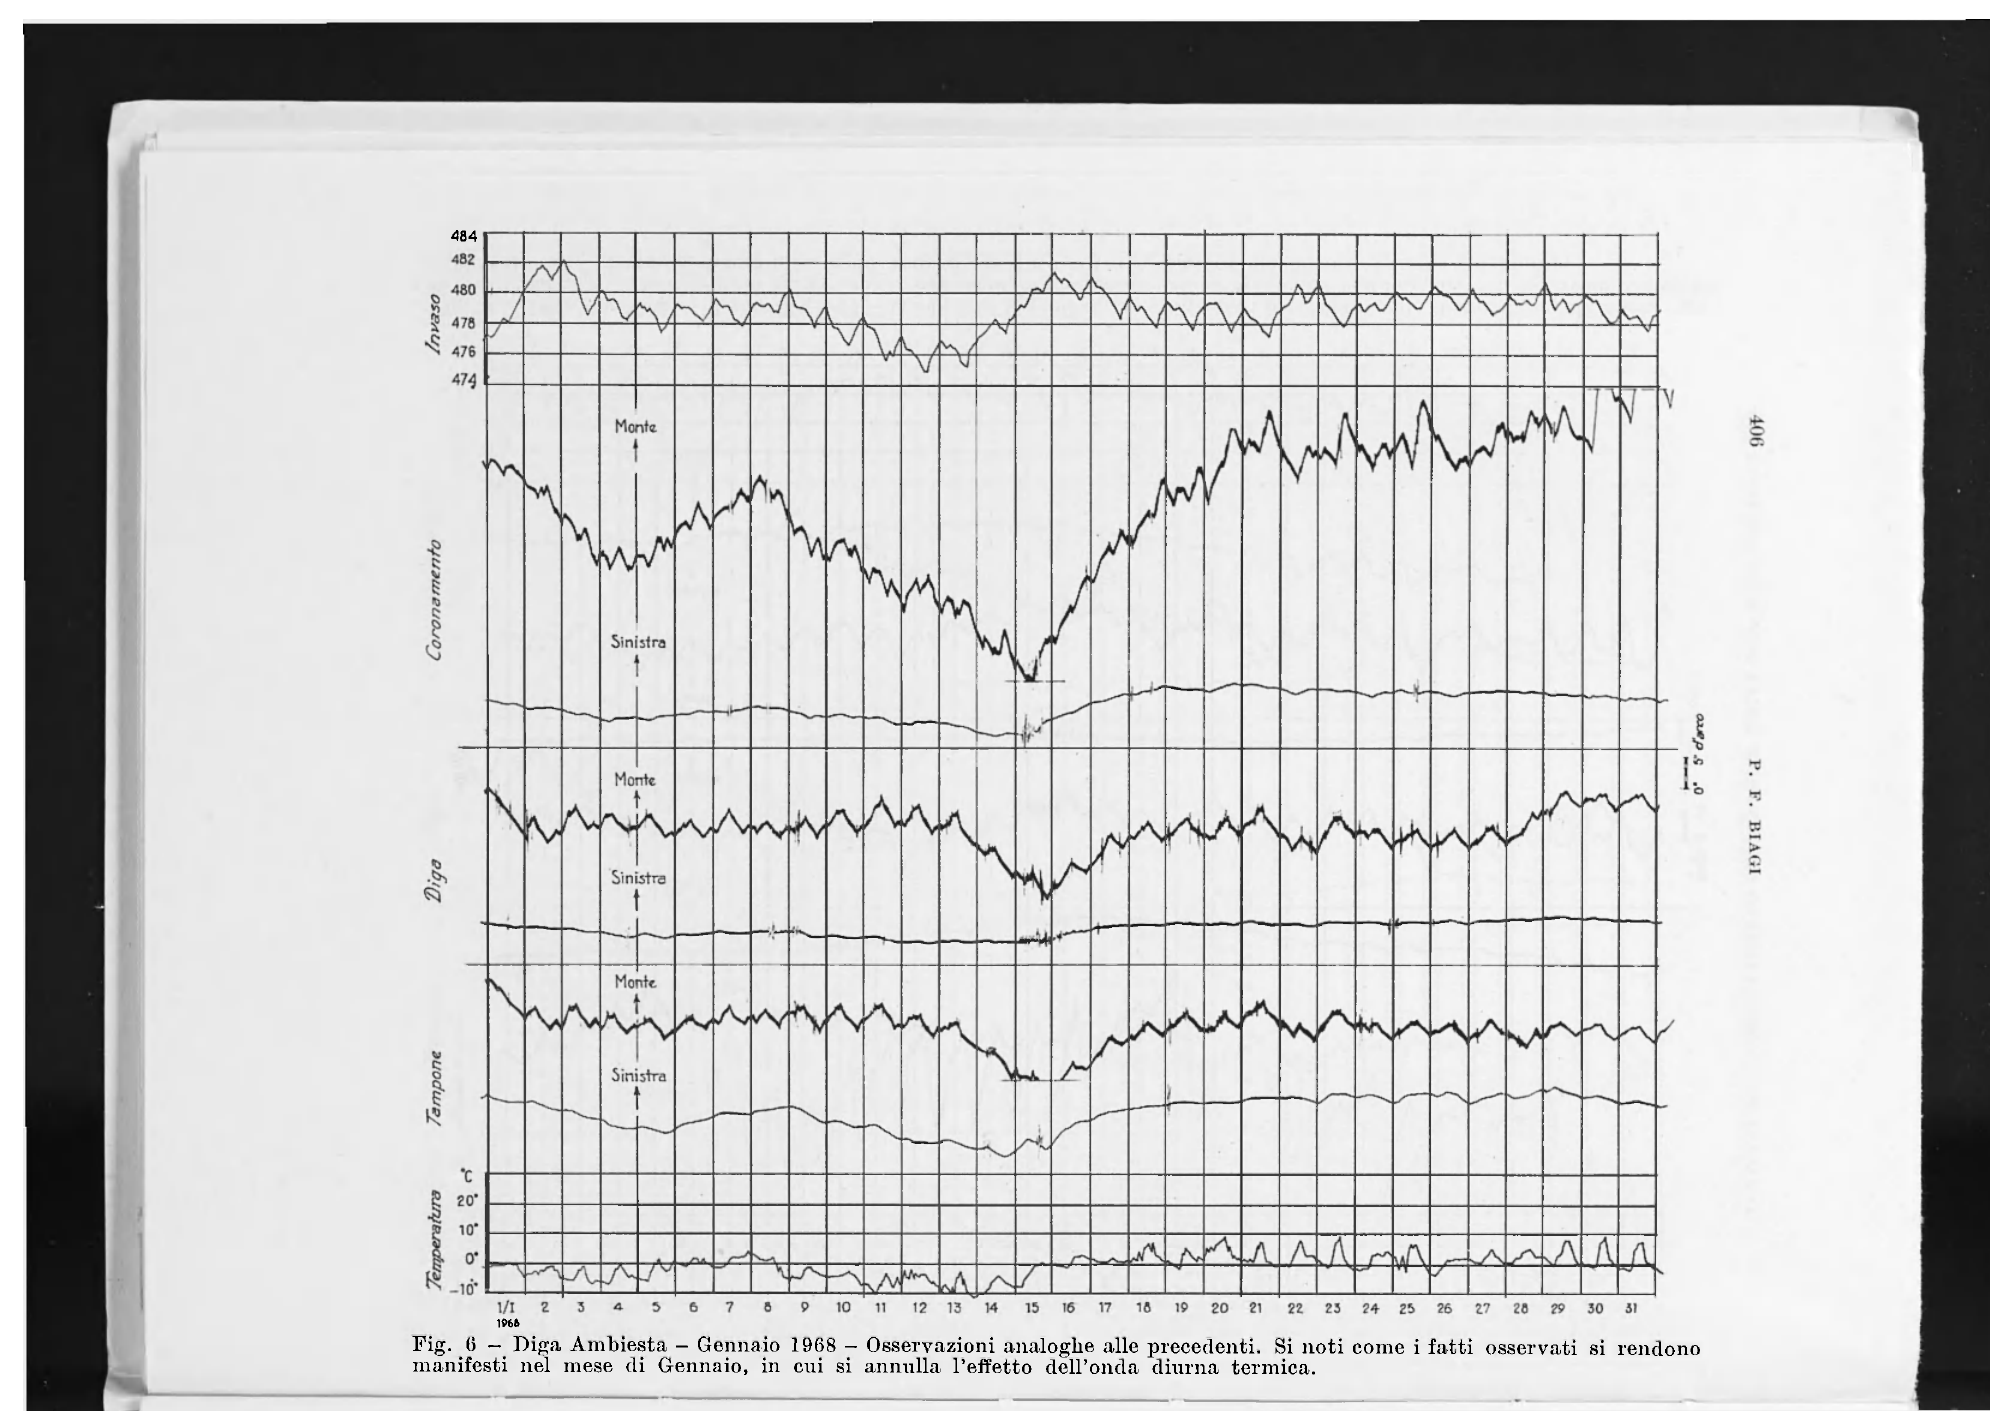
1966 Fig. (5 - Diga Ambiesta - Gennaio 1968 - Osservazioni analoghe alle precedenti. Si noti come i fatti osservati si rendono manifesti nel mese di Gennaio, in cui si annulla l'effetto dell'onda diurna